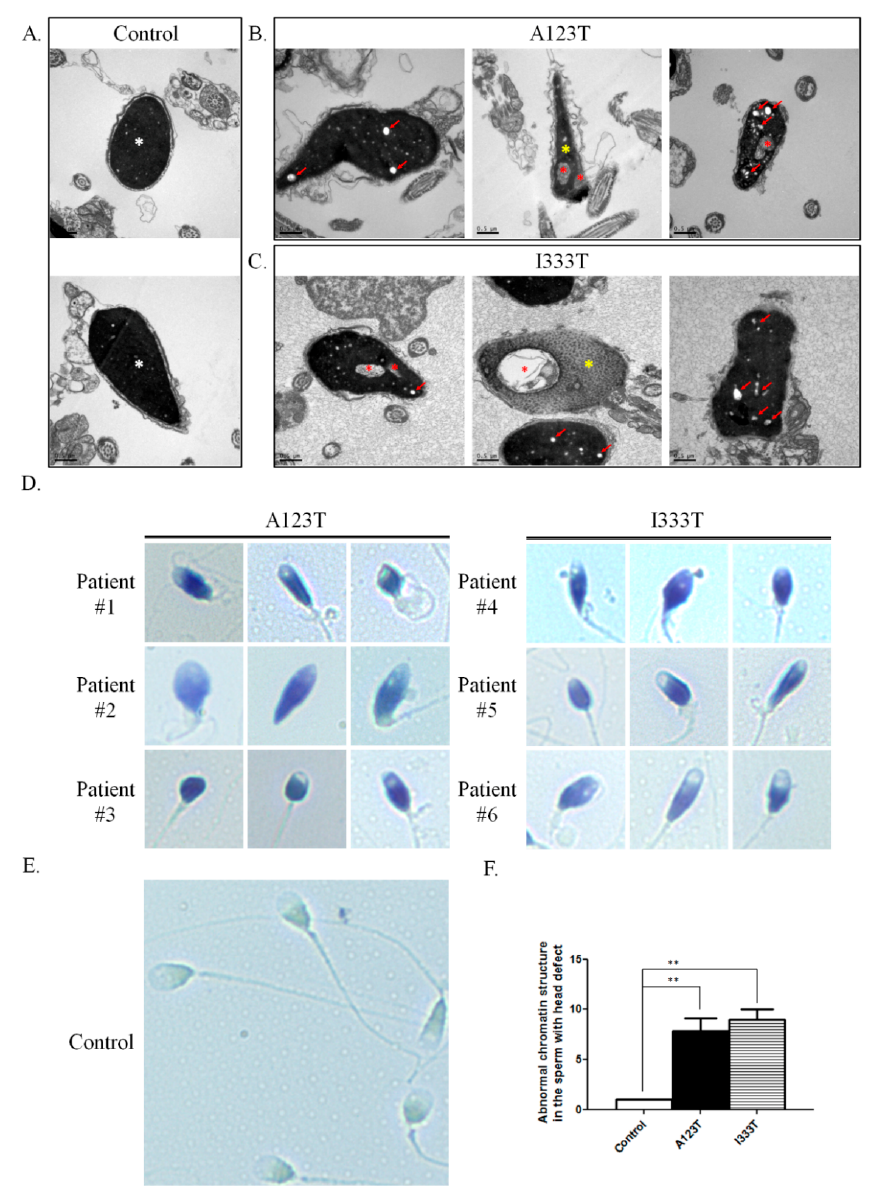
Figure 2. Sperm from patients with A123T or I333T exhibited severely malformed head shapes and aberrant chromatin